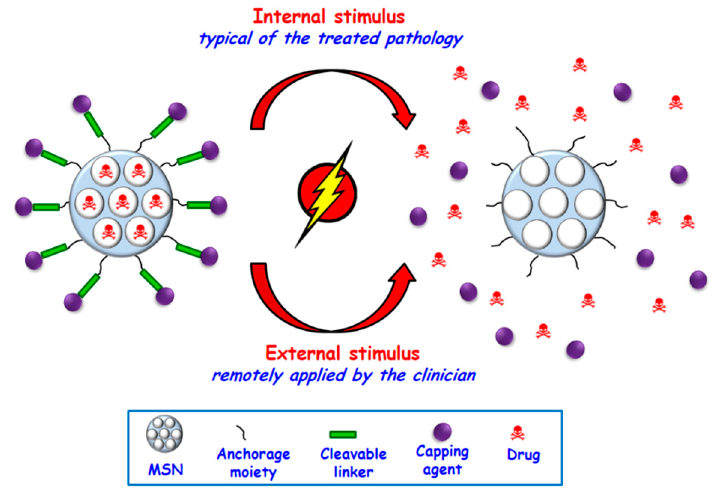
Figure 3. Schematic representation of internal or external stimuli-responsive drug delivery from MSNs.